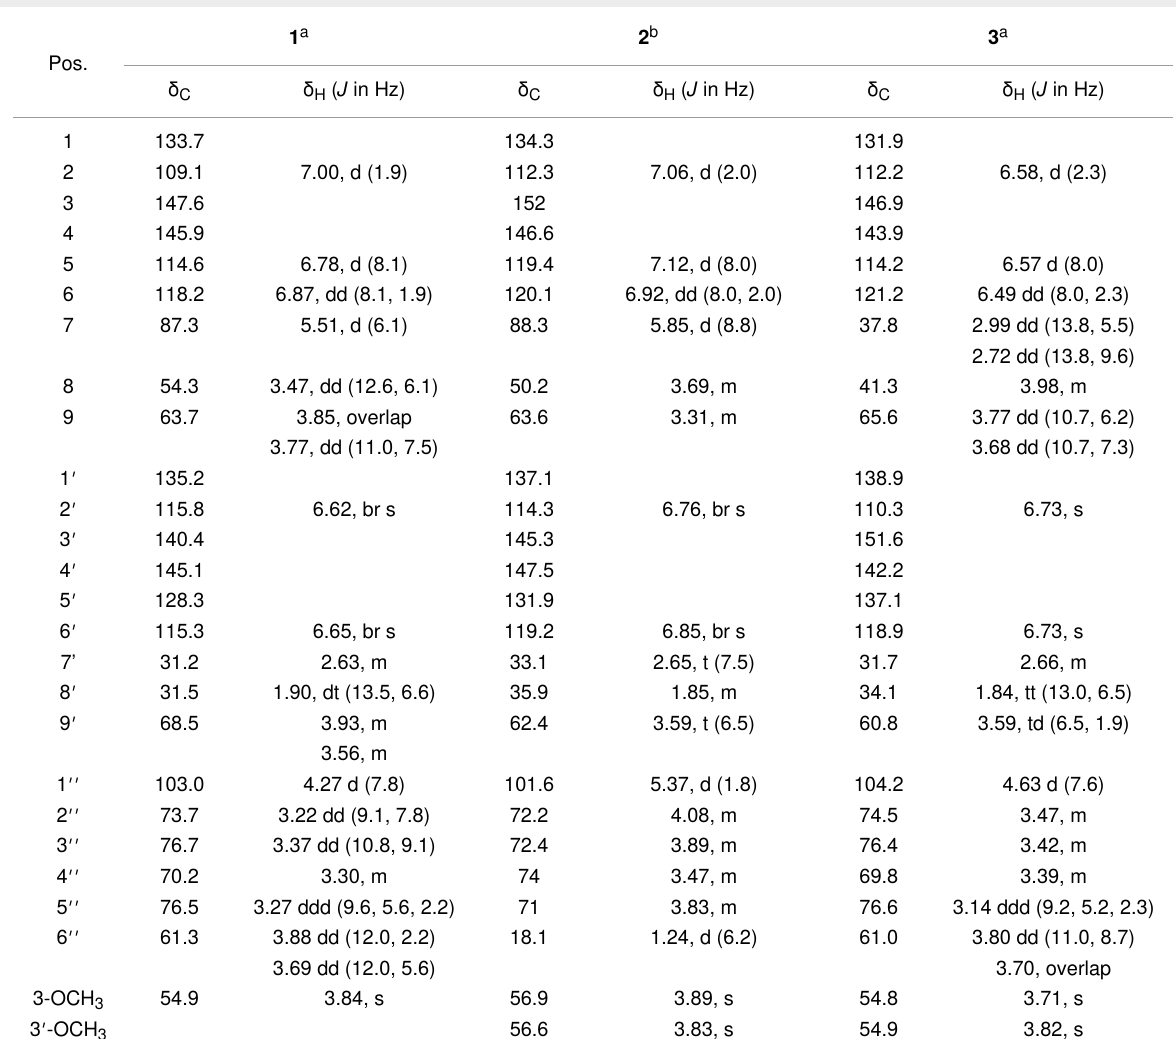
Table 1: 1 H and 13 C NMR spectroscopic data of compounds 1 – 3 in CD 3 OD.